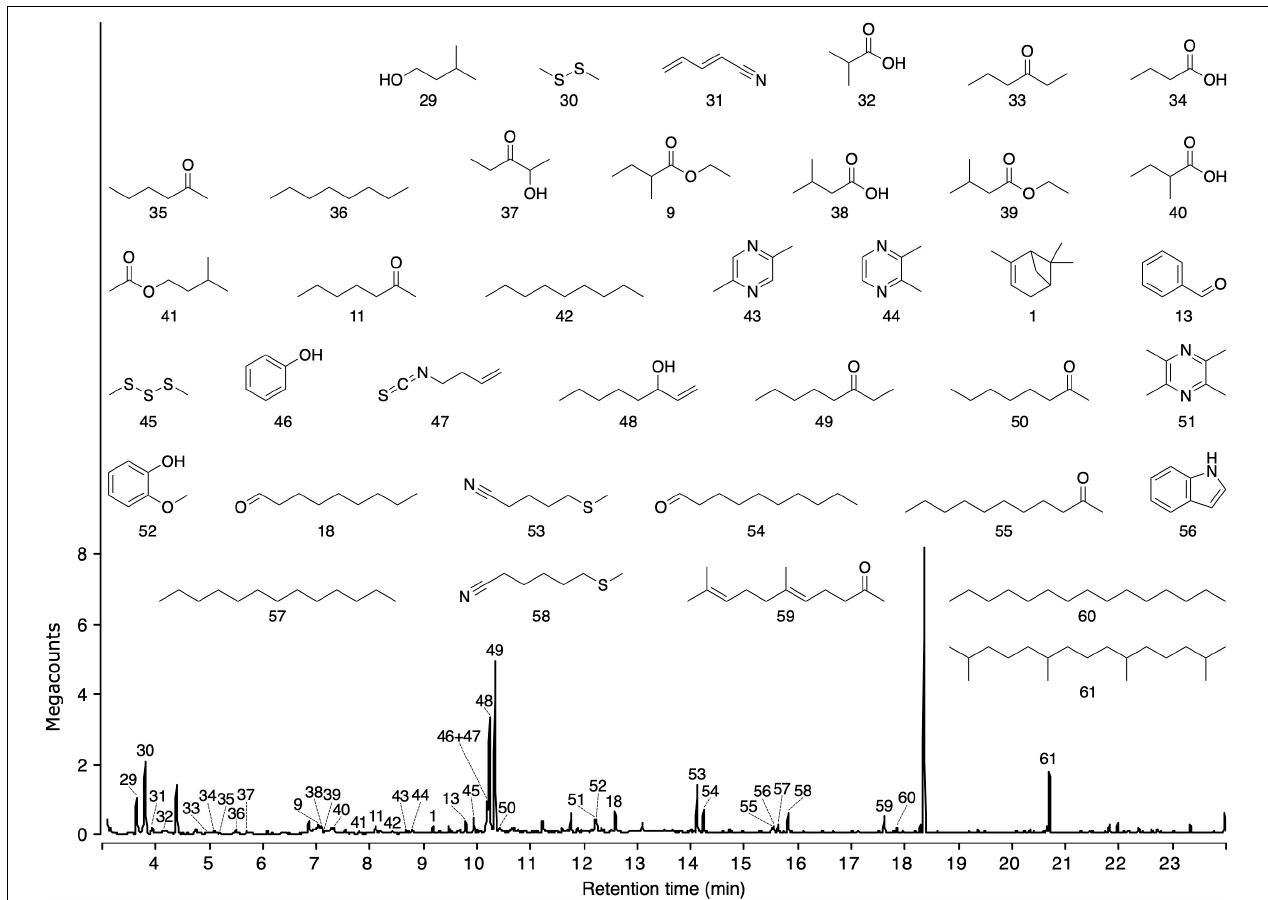
FIGURE 4 | Total ion chromatogram of headspace volatile extracts (HVEs) of excreta from Ruffs, Calidris pugnax . Headspace volatiles were adsorbed on Porapak Q ( Figure 1 ) and desorbed with pentane/ether (1/1). HVEs were analyzed by gas chromatography-mass spectrometry (GC-MS; Agilent 7890B GC coupled to a 5977A Series MSD). Names of compounds are listed in Table 2